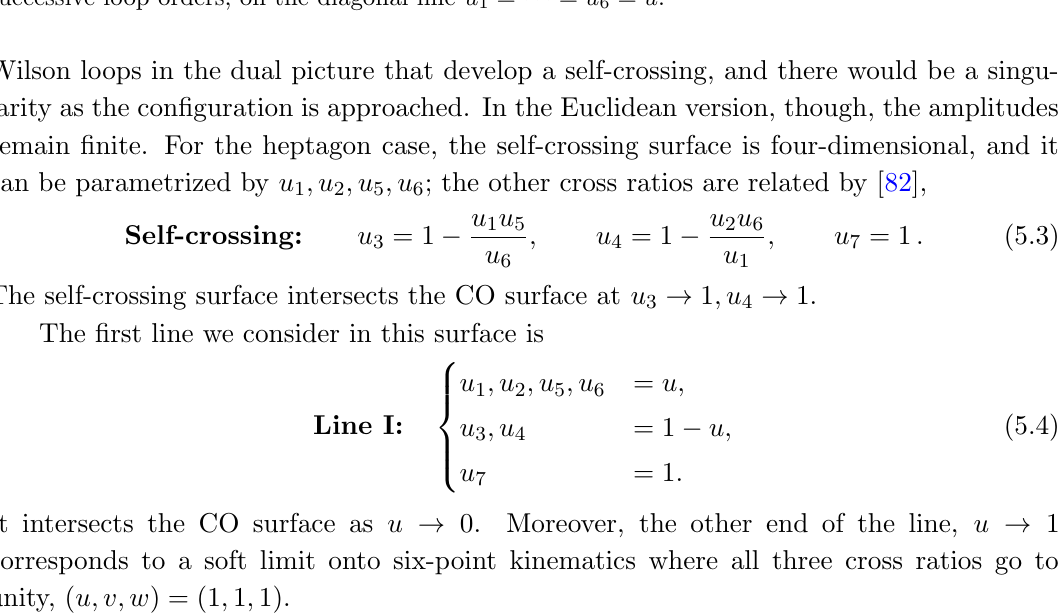
Figure 3 . Ratios of the BDS-like normalized NMHV amplitude components E 0 , E 47 and E 67 at successive loop orders, on the diagonal line u 1 = (cid:1) (cid:1) (cid:1) = u 6 = u